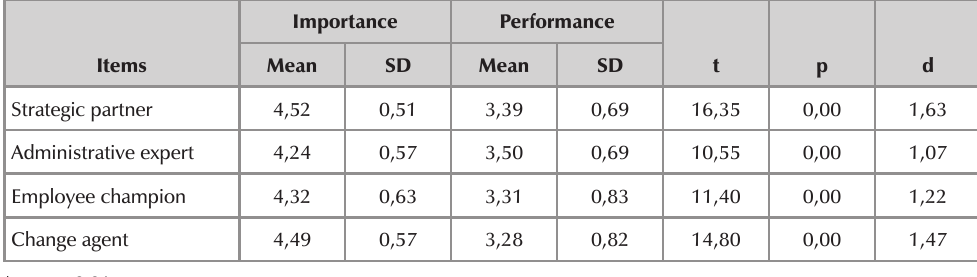
Paired samples statistics and t-test results for the human resource group (N = 128)